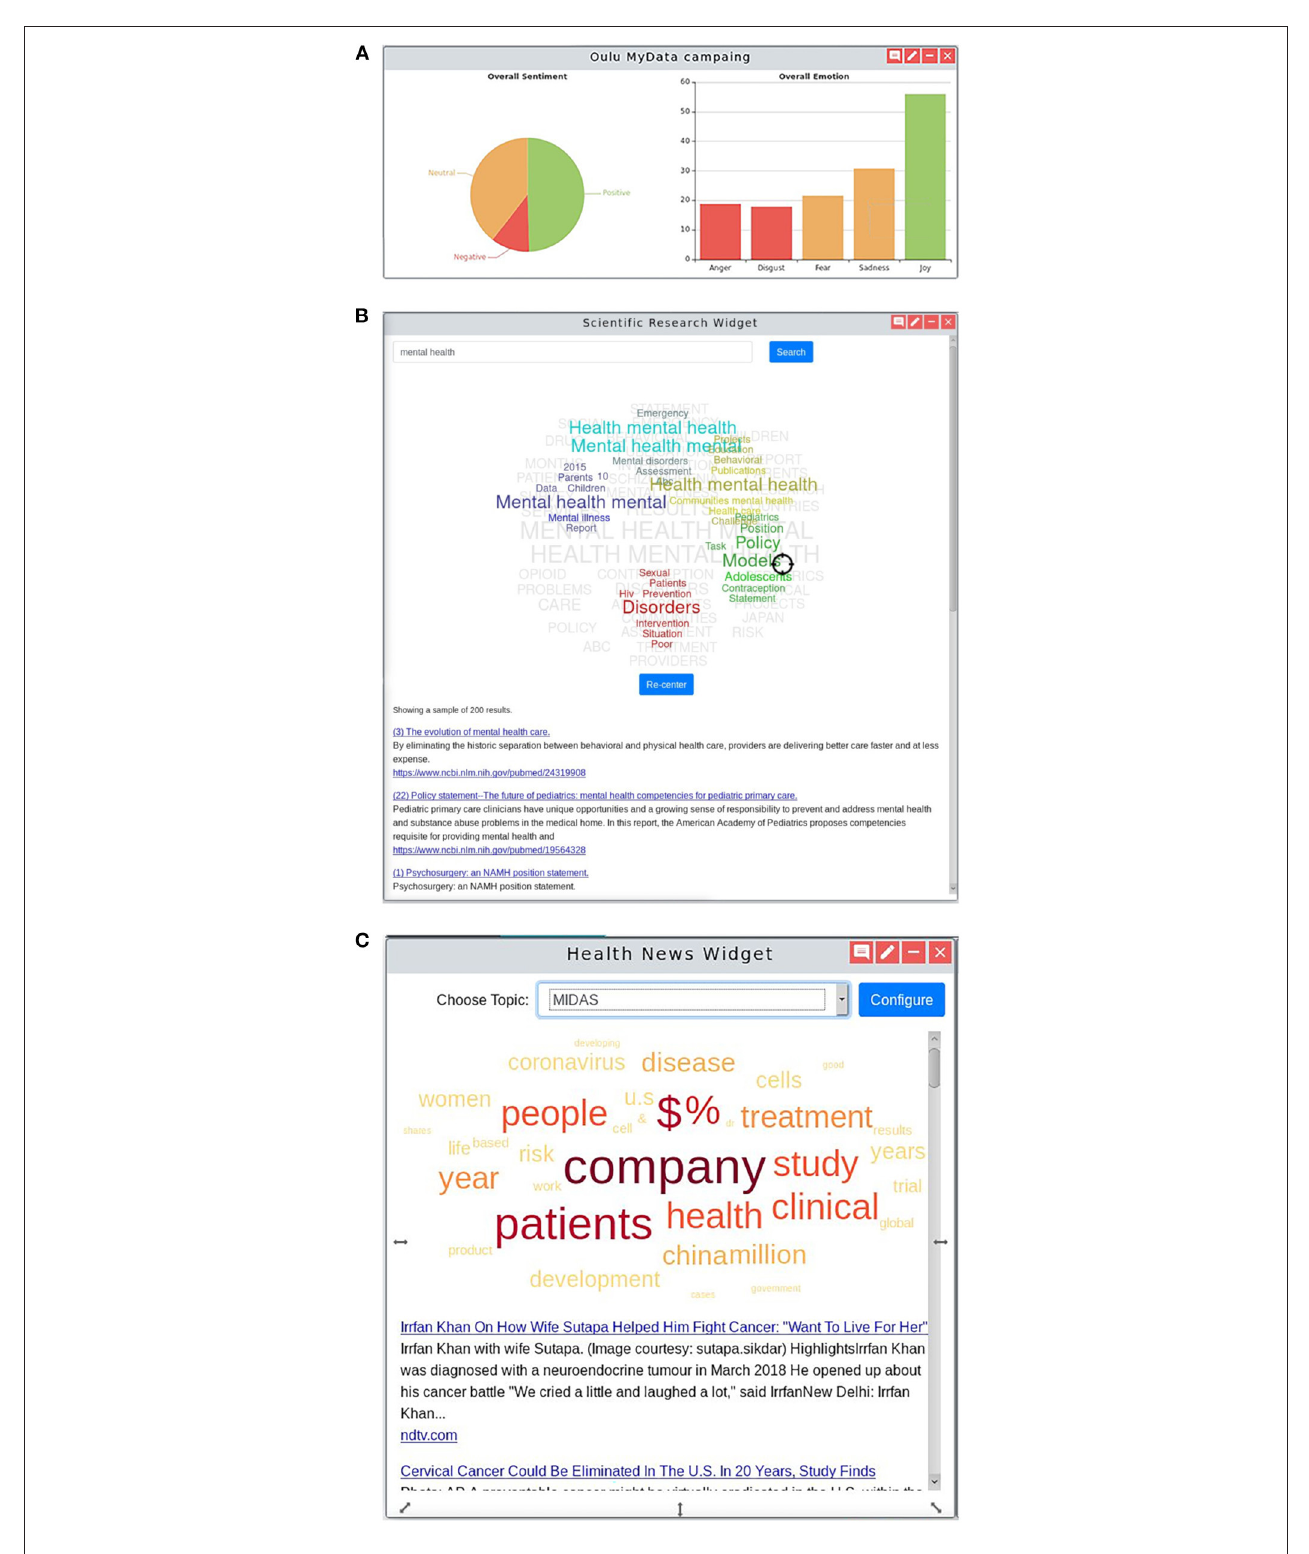
FIGURE 6 | Open and Social Analytics. (A) Social Campaign Manager shows a high-level overview of the (i) sentiment and (ii) emotional analysis of the policy being studied by a Twitter social media campaign. The sentiment and emotions found in responses to a public online survey reaching out to the public to gather their voice on